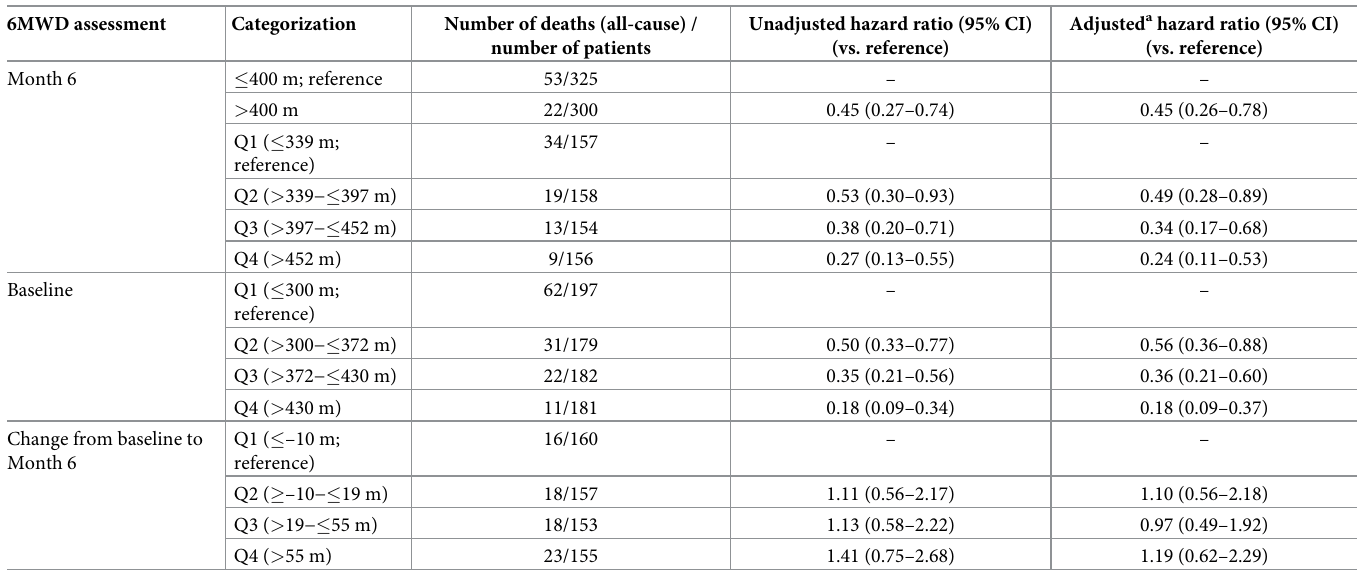
Table 2. Association between 6MWD and time to all-cause death up to end of